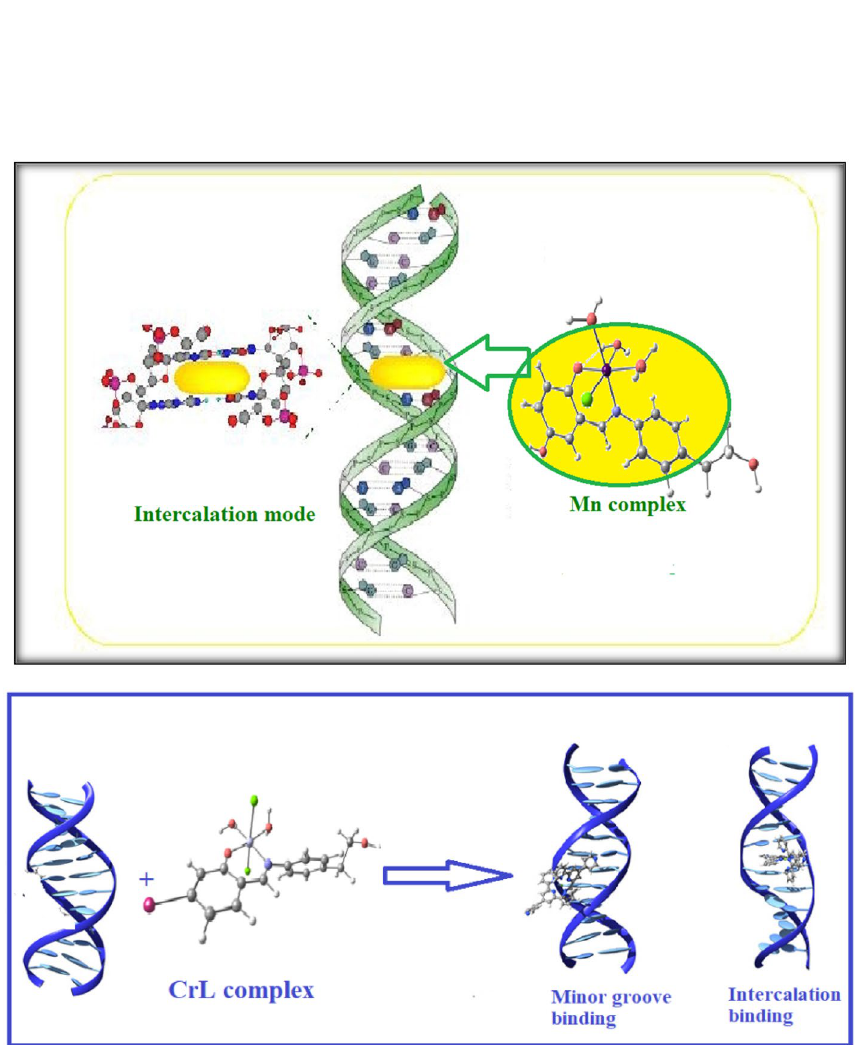
Scheme 2. Mechanism of the interaction of MnL2 and CrL2 complexes with CT-DNA through intercalation of the complex in the base pairs stack of the DNA two